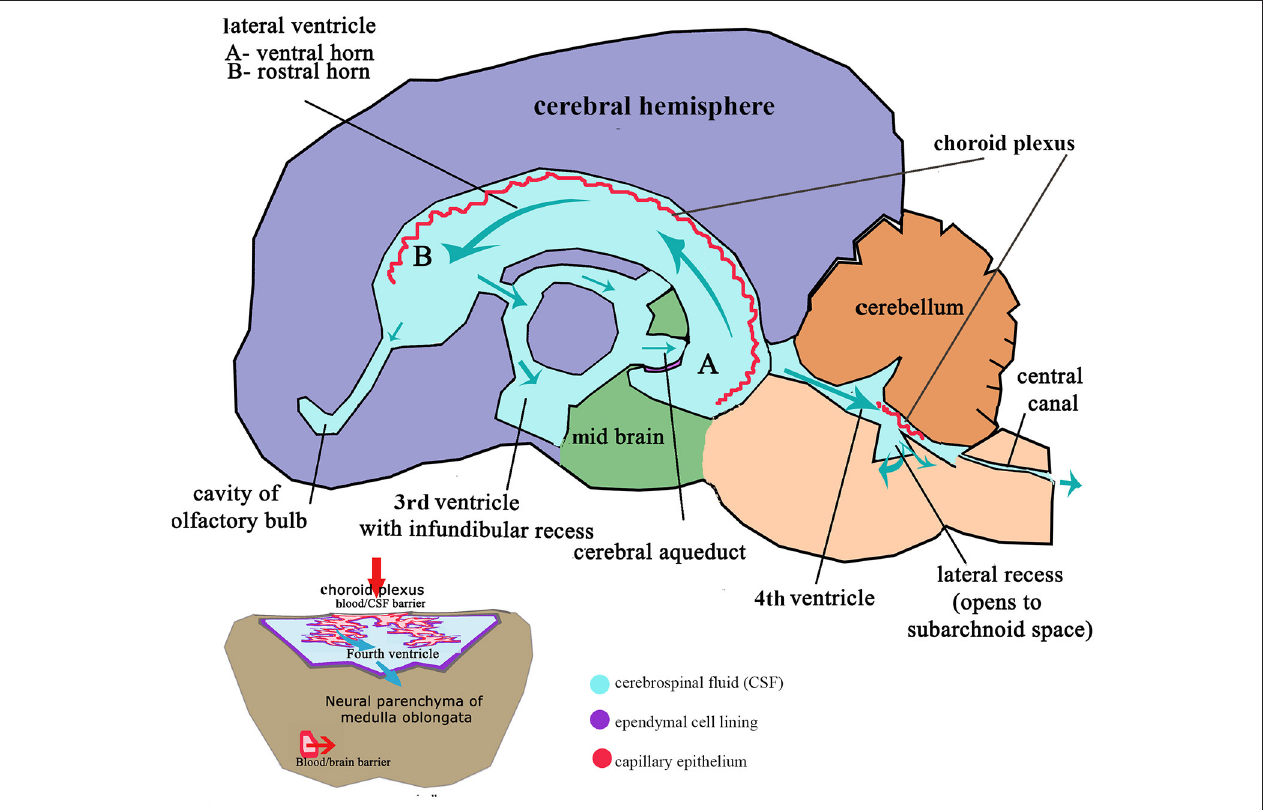
FIGURE 4 | Schematic adult brain with ventricular system with enlarged fourth ventricle inset illustrating formation of CSF. Red arrows indicate movement of filtrate from the venous system into the ventricles at the choroid plexus; Aqua arrows indicate movement of CSF through the ventricles to the subarachnoid space and central canal. Inset: Transverse section of medulla oblongata (myelencephalon) illustrating relationship of the choroid plexus epithelium invaginated into the CSF space of the fourth ventricle and the blood/brain barrier and compliance with CSF